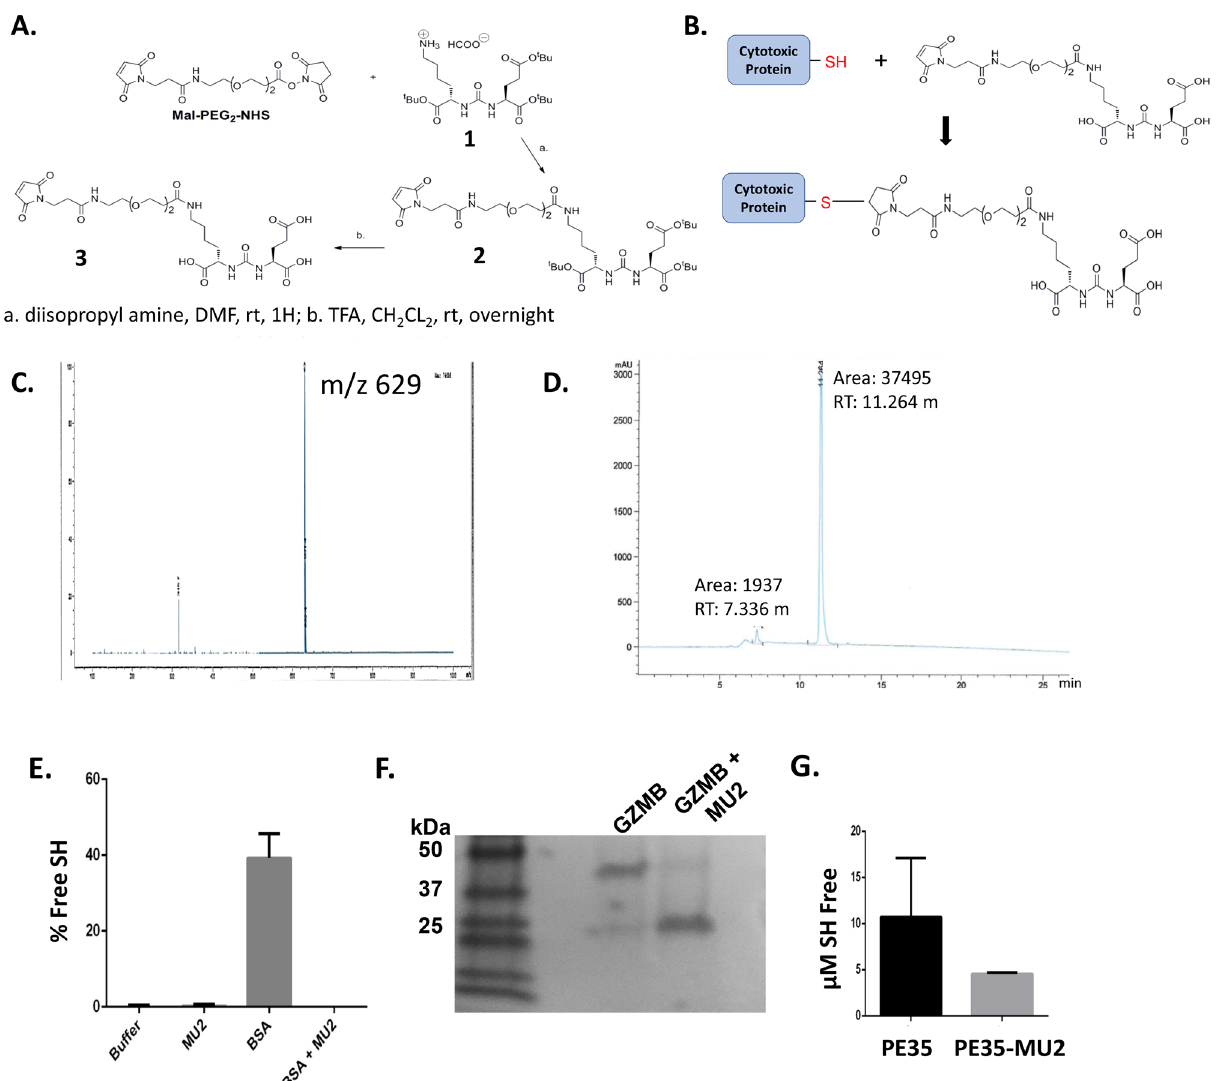
Figure 1. Synthesis and production of protein-urea drug conjugates. ( A ) Chemical synthesis scheme taken to make a thiol-reactive maleimide-linked urea separated by two PEG units (MU2). ( B ) Diagram depicting the protein-MU2 conjugation reaction. ( C ) Mass spectrometry and ( D ) HPLC plot of MU2 product. ( E ) Ellman’s reagent assay of BSA +/− MU2 under non-reducing conditions. ( F ) Non-reducing SDS PAGE gel of C-terminal reactive GZMB +/− MU2 following dialysis. ( G ) ABD-F fluorescent assay of PE35 +/−